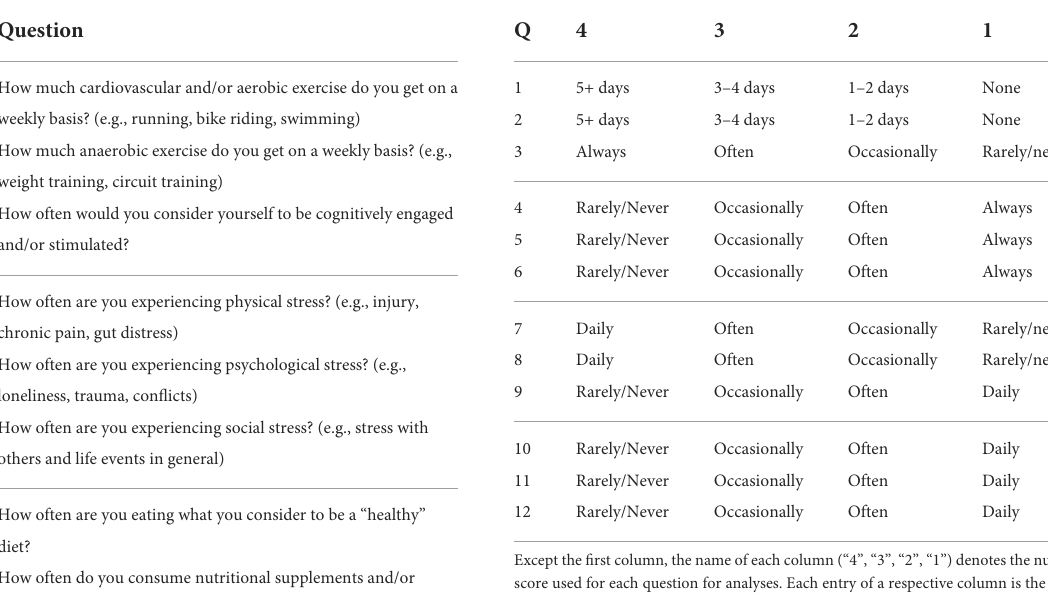
TABLE 1 The 12 questions on the questionnaire. TABLE 2 Scoring scheme.